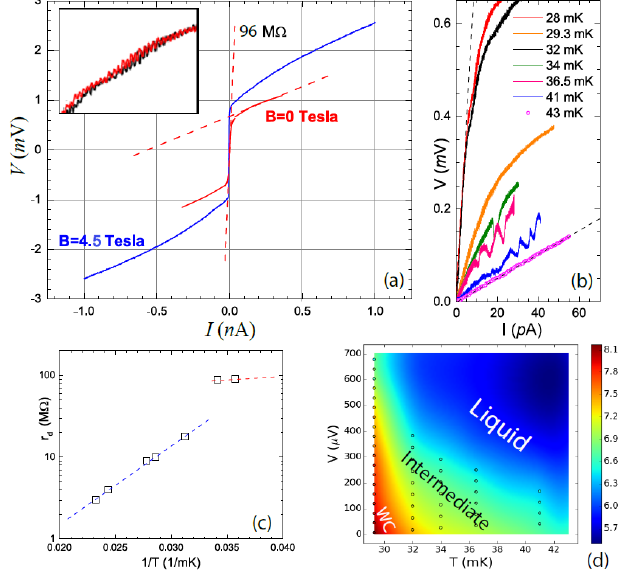
Figure 8. Voltage-current characteristics of 2D holes in GaAs in a possible WC state to show the two-stage melting of the WC. ( a ) dc IV at 28 mK. ( b ) IVs at different temperatures. ( c ) Temperature dependence of r d ( T ) | V → 0 . ( d ) Suggested phase diagram. Figure from Reference [36].